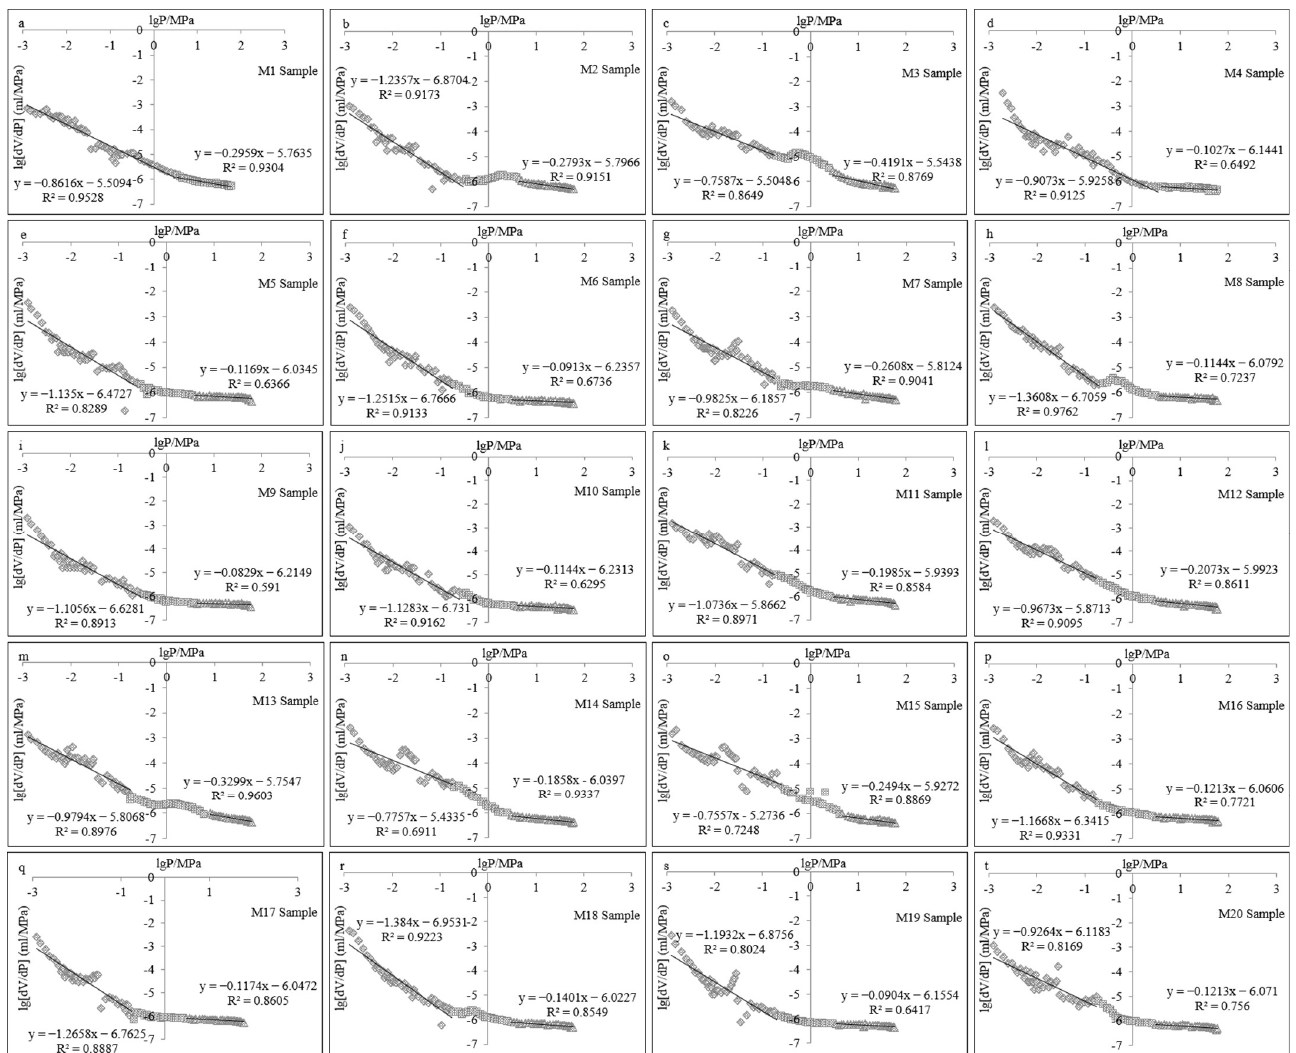
Figure 5. Comparison of the Menger fractal models in the ( a – t ) based on the HPMI data of coal samples M1-M20, respectively.